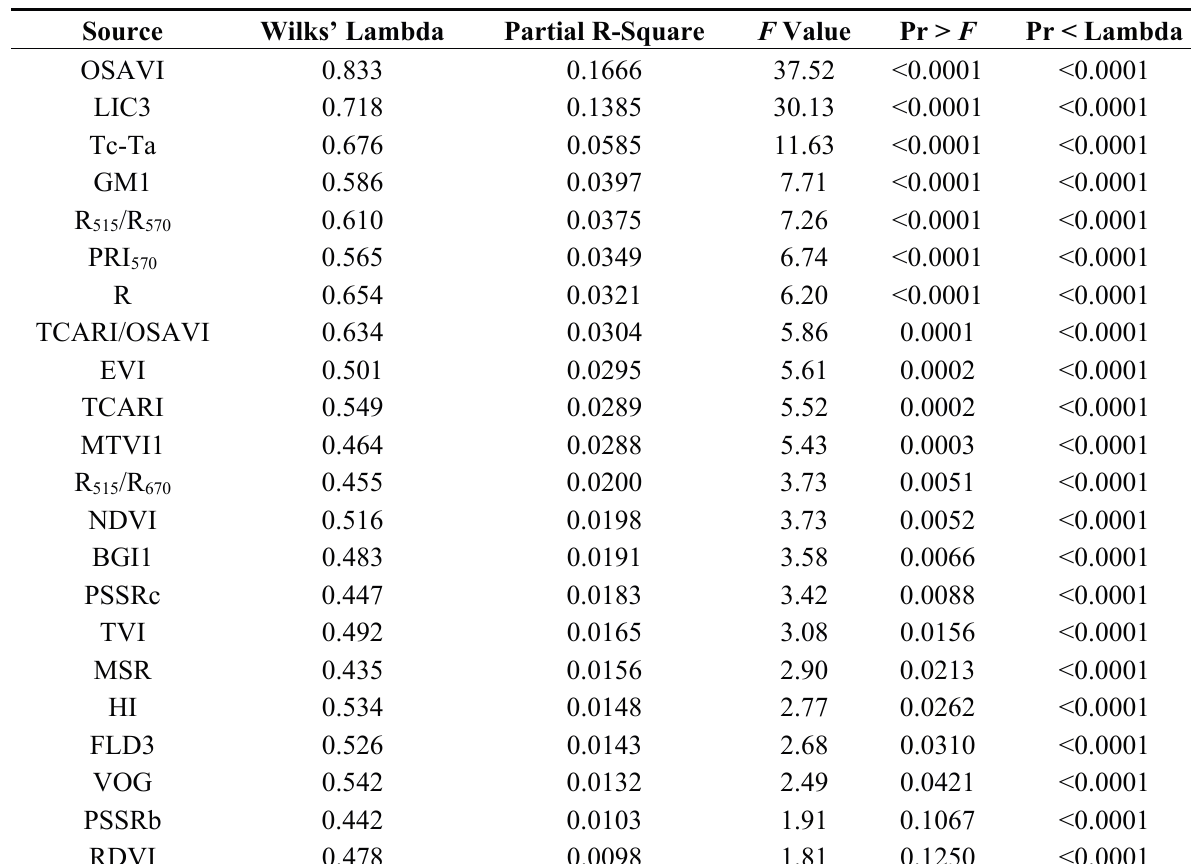
Table 4. Variables selected from normalized canopy temperature (Tc-Ta) and vegetation indices in the forward stepwise discriminant analysis to determine the severity of Verticillium dahliae infection in olive